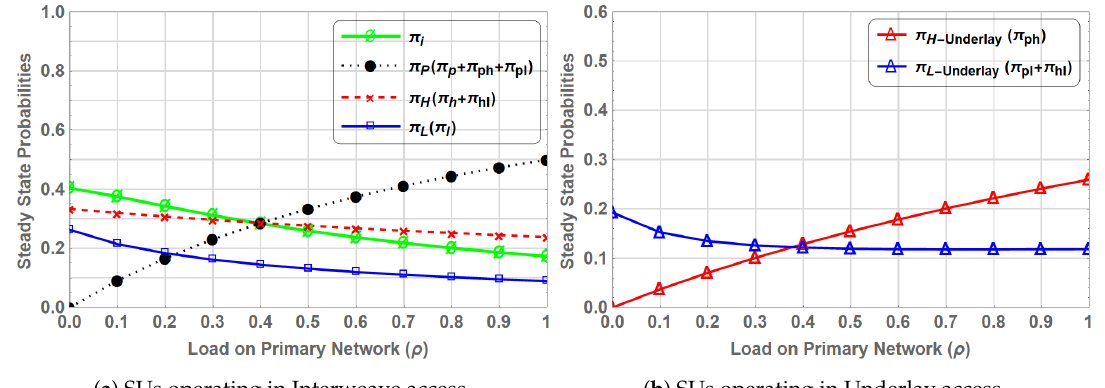
Figure 10. Stationary probabilities for PN-MC-HB.